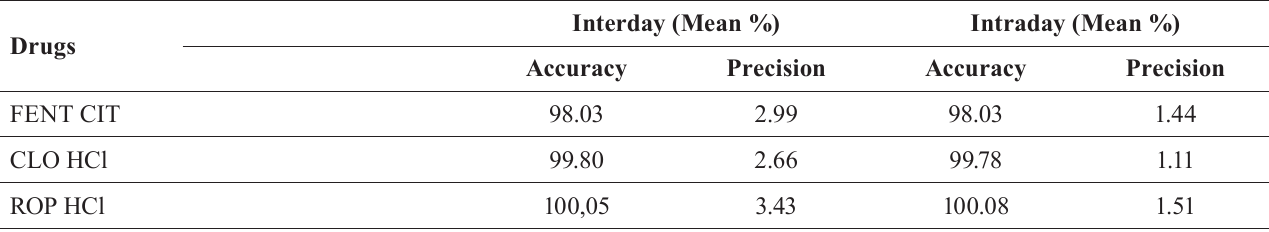
TABLE III - Results of interday and intraday accuracy and precision of the analytical methods (n=3 for three concentrations levels)